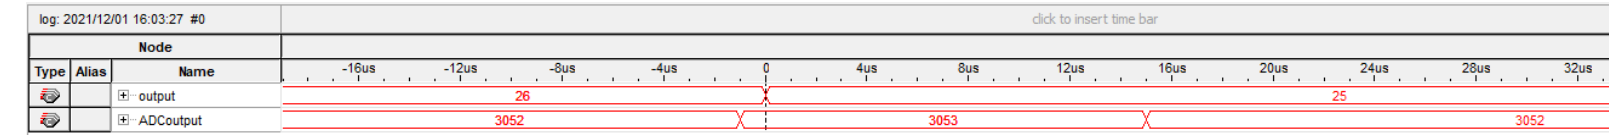
Figure 24. Synchronism evaluation for a stimulus